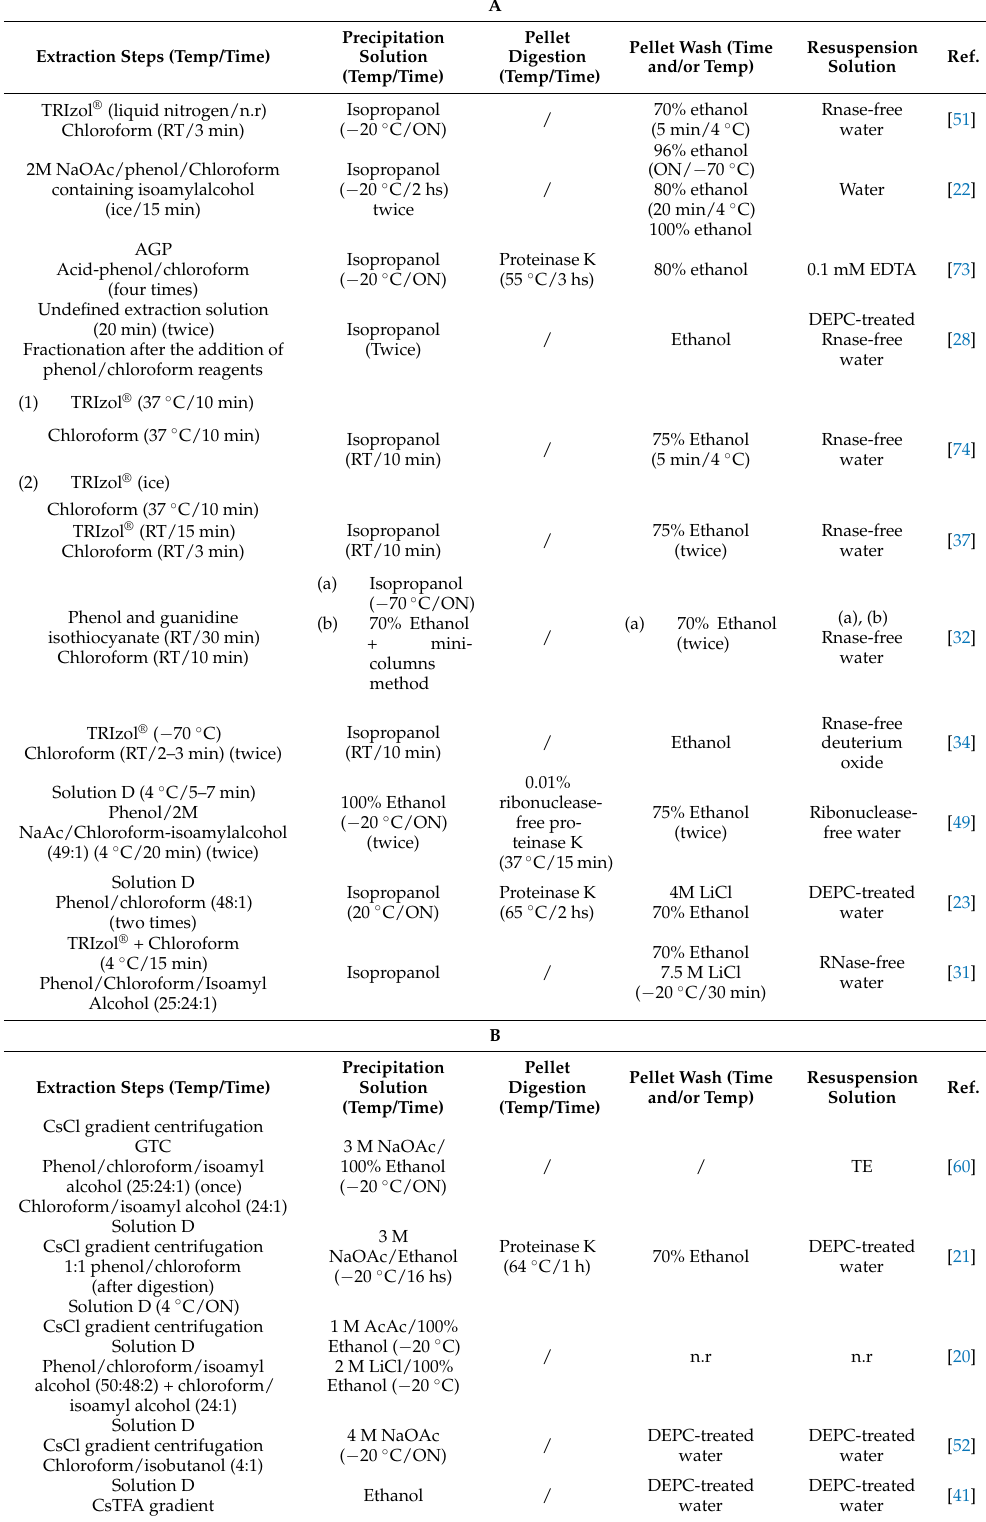
Table 4. Solutions, temperatures, and times employed in the RNA extraction procedures. ( A ) Modifi- cation of the phenol-chloroform technique; ( B ) protocols that utilize CsCl or CsTFA